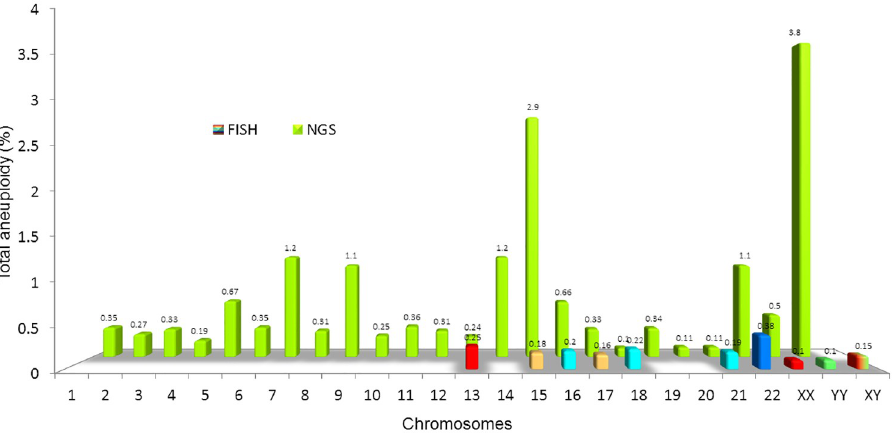
Fig 3. Aneuploidy comparison per chromosome by FISH and NGS. Aneuploidy assessment by FISH, when compared to NGS, appears minute. This dramatic difference between the two assays demonstrates the sensitivity of the NGS